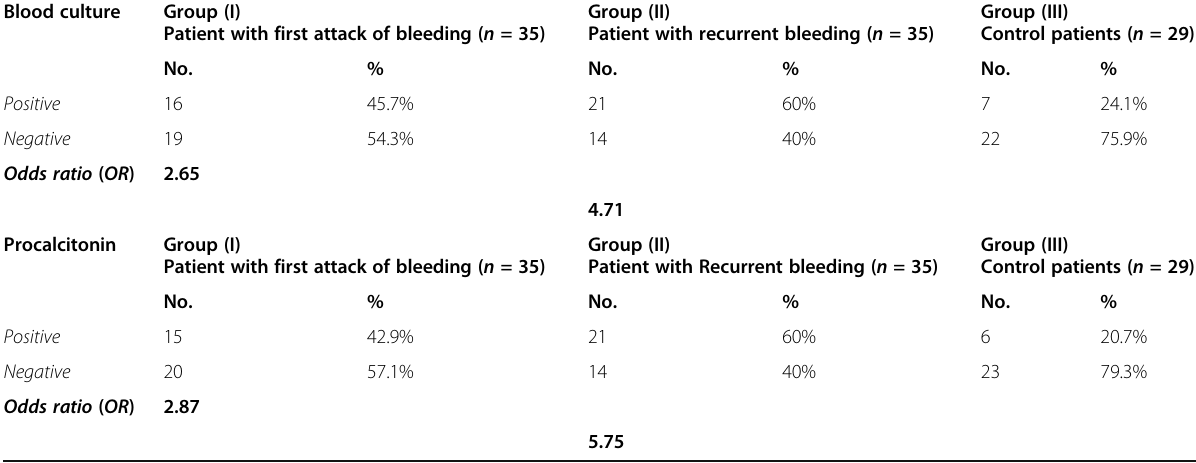
Table 5 Assessment of bacteremia and positive procalcitonin as a risk for gastrointestinal bleeding among studied population ( n = 99) Blood culture